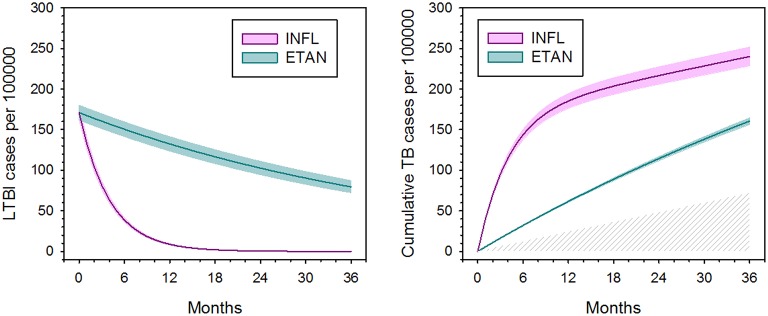
Apparent effect of tumor necrosis factor blockade on latent tuberculosis infection (left) and total number of active tuberculosis cases (right), based on hidden Markov modeling and Monte Carlo simulation. Colored shading indicate 95% confidence intervals. Latent TB infection is defined functionally by its capacity to reactivate. The hatched area (right) indicates TB cases arising due to new infection, which occur equally for both agents. Adapted from (Wallis, 2008), with permission.